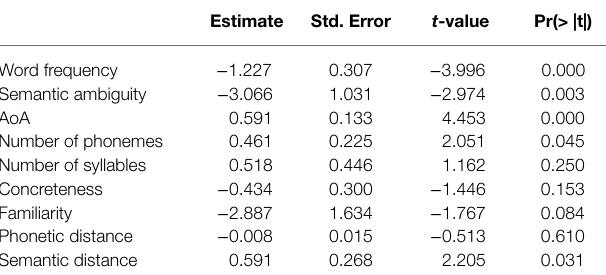
TABLE 5 | Results of separate linear mixed-effects models of the relation between task time and the language measures. Estimate Std. Error t -value Pr(>